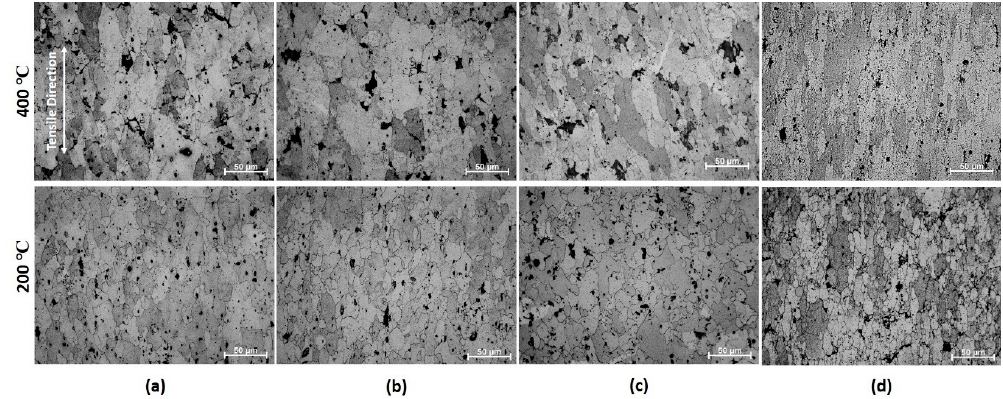
Figure 4. Optical micrographs of ( a ) as-received (AA 7075-T6 aluminum alloy), ( b ) the solution heat-treated material, ( c ) sample processed in a die with a temperature of 24 ◦ C, and ( d ) sample processed in a die with a temperature of 350 ◦ C. All micrographs highlight microstructure evolution after tensile tests at the strain rate of 0.01 s − 1 and temperatures of 200 ◦ C (lower row) and 400 ◦ C (upper